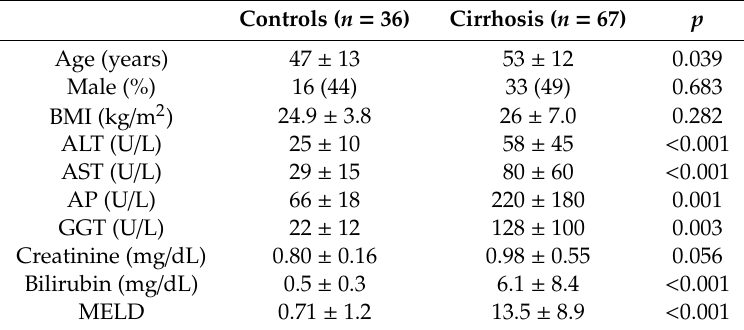
Table 1. Demographic and clinical parameters of the study population.